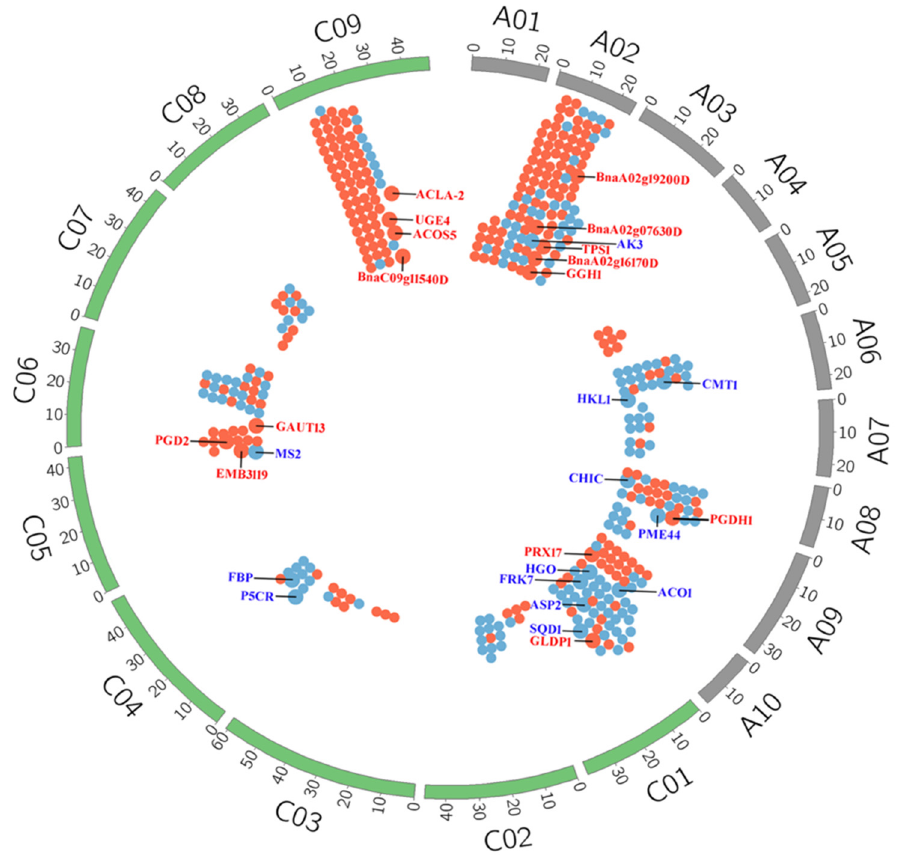
Figure 4. The distribution of the DEGs involved in KEGG pathways on B. napus genome. A01-A10 indicates 10 chromosomes of A genome in B. napus ; C01-C09 indicates 9 chromosomes of C genome in B. napus . Red dots indicate up-regulated genes and blue dots indicate down-regulated genes. Large dots indicate 30 DEGs closely related to lignocellulose synthesis.